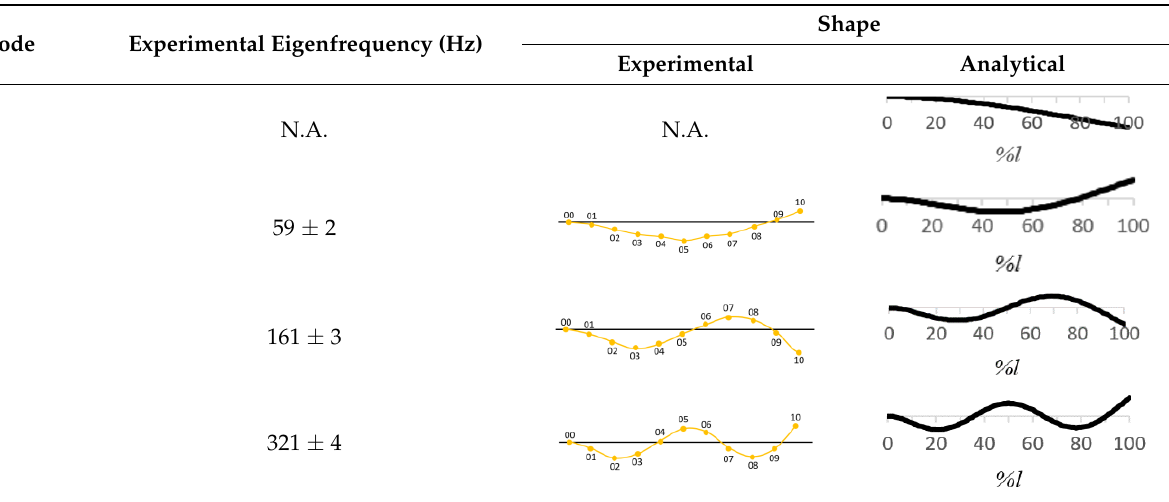
Table 2. Experimental dynamic Young’s modulus.